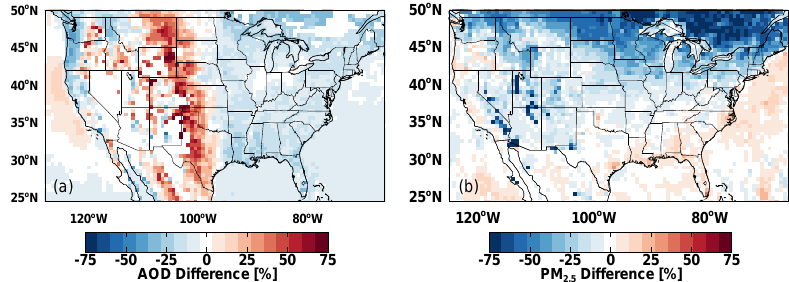
Figure 6. (a) Percent difference between annual mean AOD from MODIS Collection 6 and Collection 5 and (b) simulated bias in satellite- derived annual average surface PM 2 . 5 associated with satellite